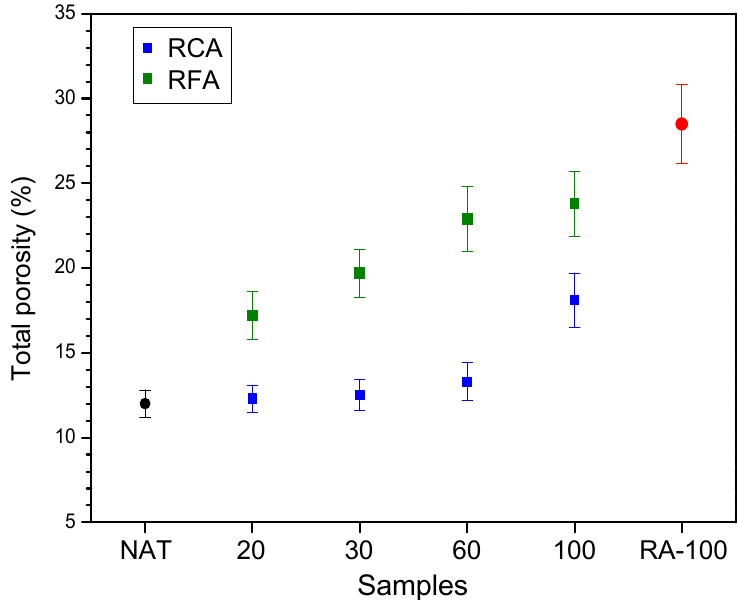
Figure 8. Total porosity of the studied mixtures.